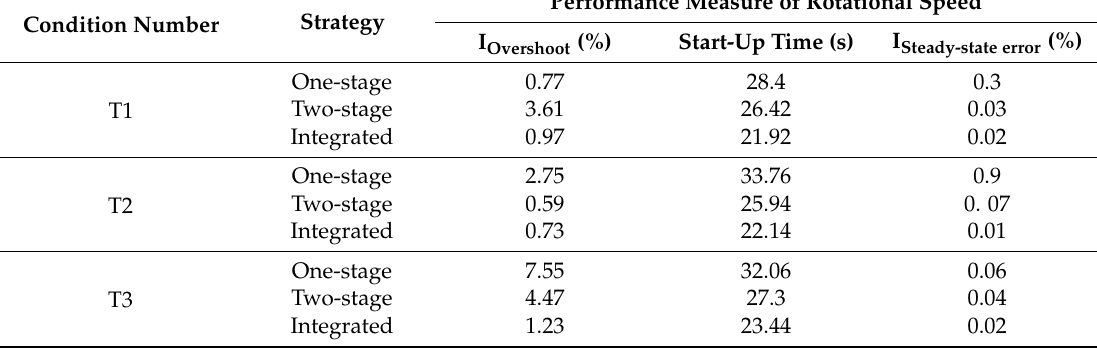
Table 15. Performance indices of the variable start-up strategy of PSU under different water head conditions.